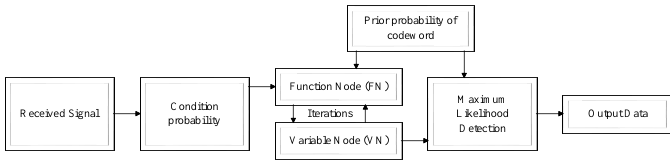
Figure 4. Block diagram of an MPA